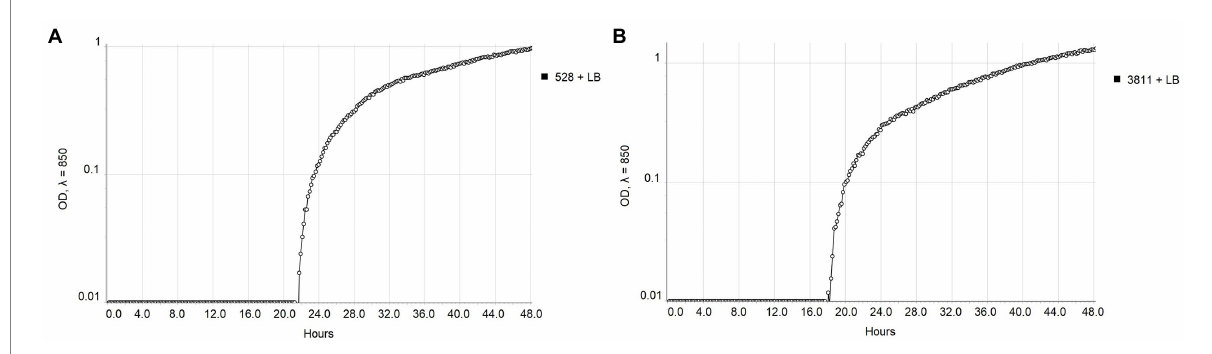
FIGURE 1 Comparison of the growth of untreated Xanthomonas campestris pv. campestris strains (A) NCPPB 528 T and (B) WHRI 3811 measured by Cell Growth Logger (OD 850 , 48 h period, log 10